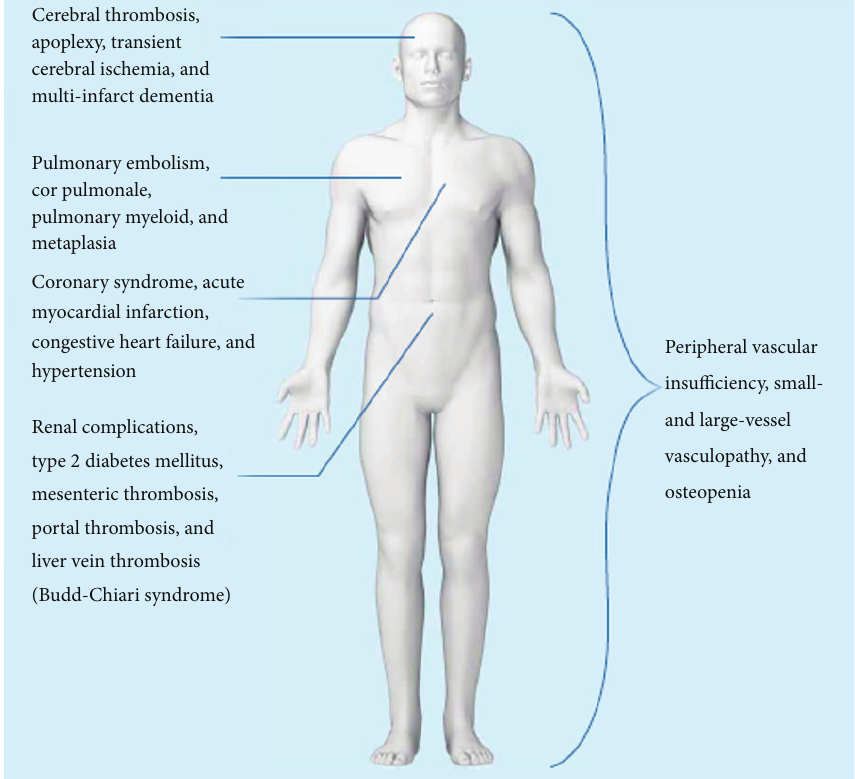
Figure 2: Patients with MPNs have a massive cardiovascular and thromboembolic disease